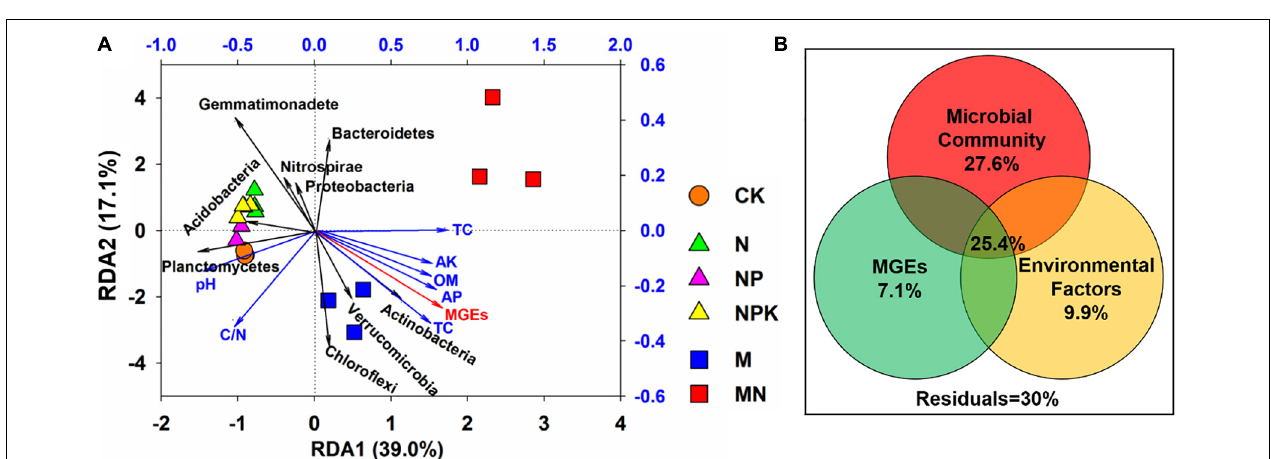
FIGURE 6 | Correlations between ARG subtypes and bacterial taxa were processed by network analysis. Each node was colored based on ARG type and microbial taxa. Each connection indicates a strong (Spearman’s correlation coefficient r 2 > 0.36) and significant ( P < 0.01) correlation. Edges are dependent on the coefficient values, and node size is weighted based on the relative abundance of ARGs/bacterial taxa. MLSB, macrolide-lincosamide-streptogramin B.